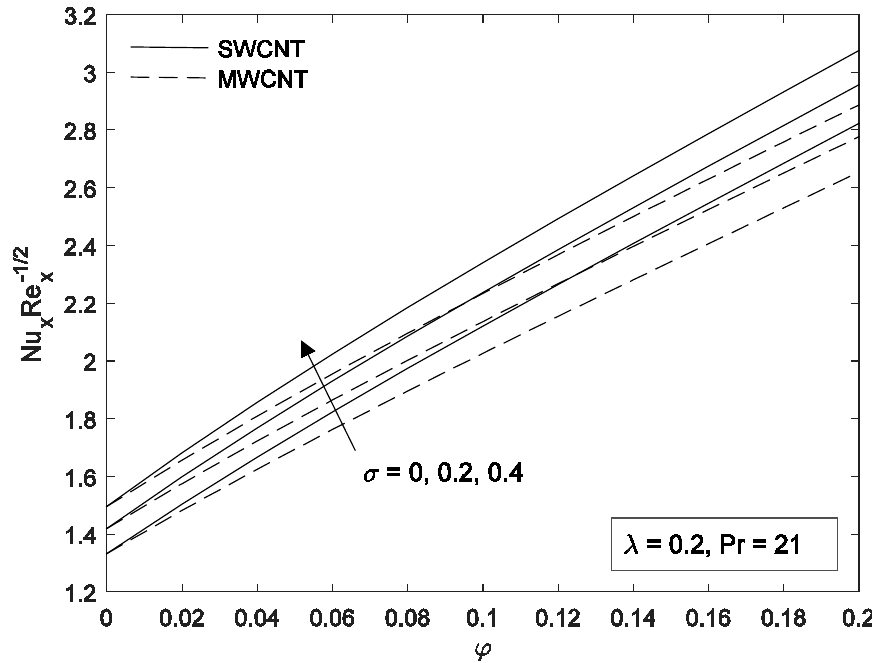
Figure 13. Effect of σ on Nusselt number for kerosene-based fluid.